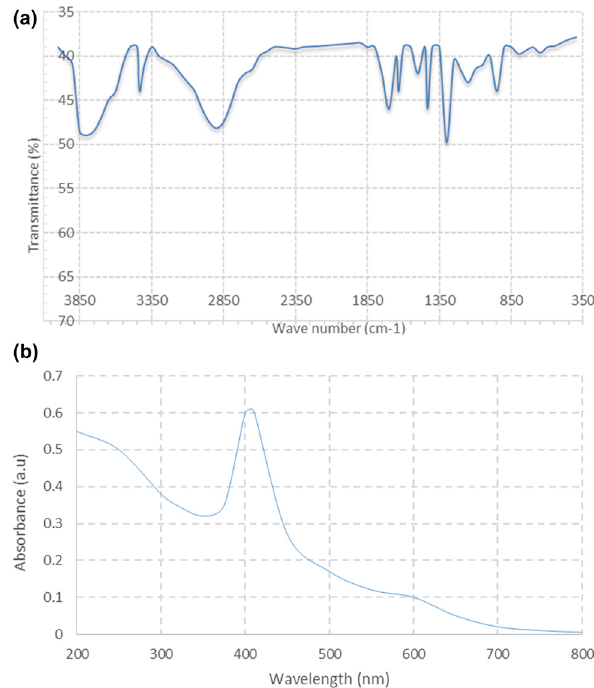
Figure 5: FT - IR ( a ) and UV - Vis absorbance ( b ) spectra of the optimum sodium alginate/AAc composite hydrogels conjugated to silver